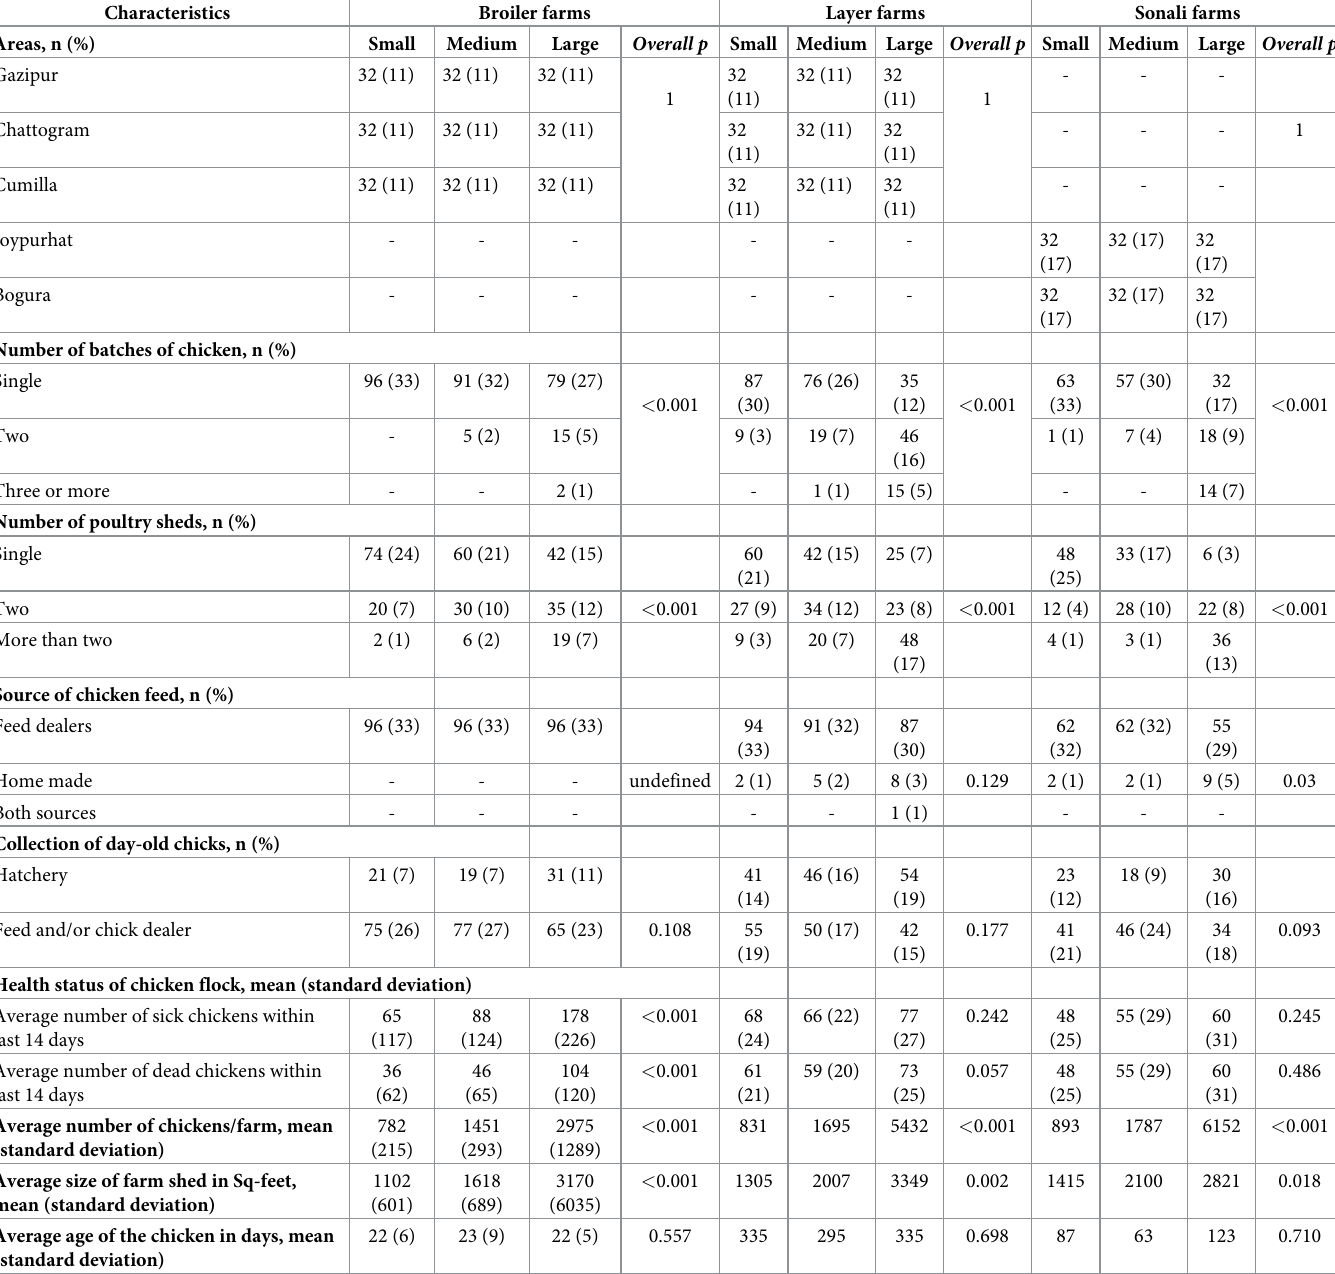
Table 1. Demographic and health characteristics of commercial broiler (n = 288), layer (n = 288) and Sonali (n = 192) chicken farms sampled during January to May 2021 in Bangladesh.